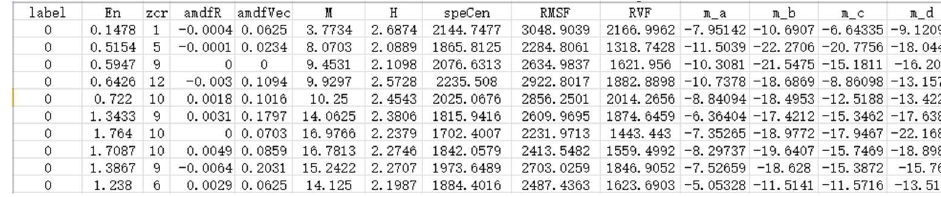
Figure 7. Validation data set to be predicted.